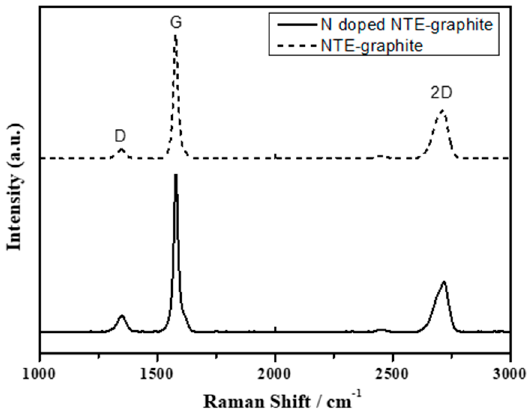
Figure 4. Raman spectra of untreated NTE-graphite (dotted line) and N-doped NTE-graphite (solid line).